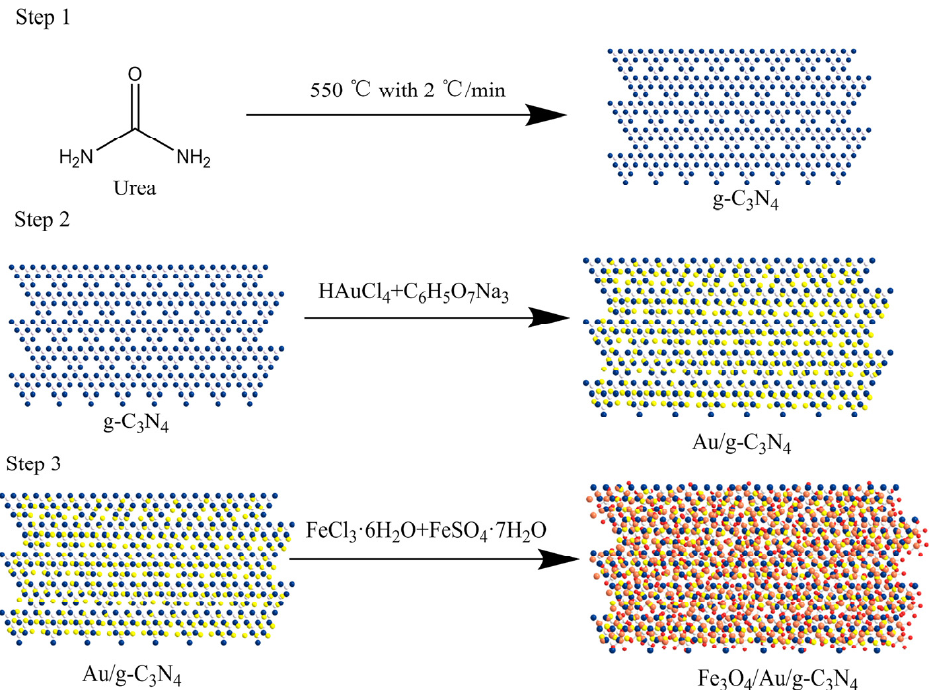
Figure 1. Fe 3 O 4 /Au/g-C 3 N 4 synthesis path: Step 1: Preparation of g-C 3 N 4 by heating with urea. Step 2: Preparation of Au/g-C 3 N 4 by heating g-C 3 N 4 , HAuCl 4 and C 6 H 5 O 7 Na 3 . Step 3: Preparation of Fe 3 O 4 /Au/g-C 3 N 4 by heating Au/g-C 3 N 4 , FeCl 3 ·6H 2 O and FeSO 4 ·7H 2 O.